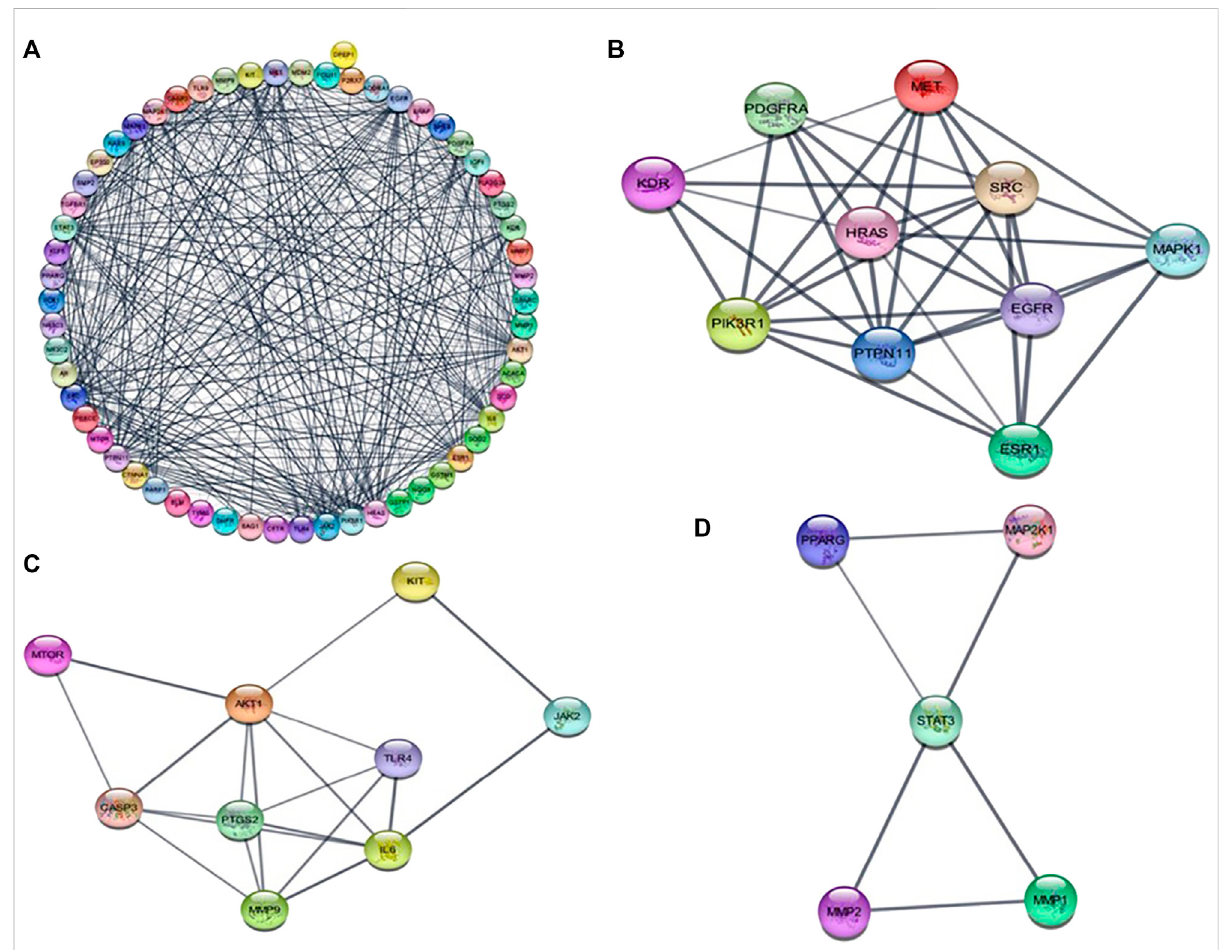
FIGURE 3 (A) protein-protein interaction network diagram of 63 intersected DEGs between andrographolide and CRC. (B – D) represents those three modules obtained from the PPI network using MCODE plugin in